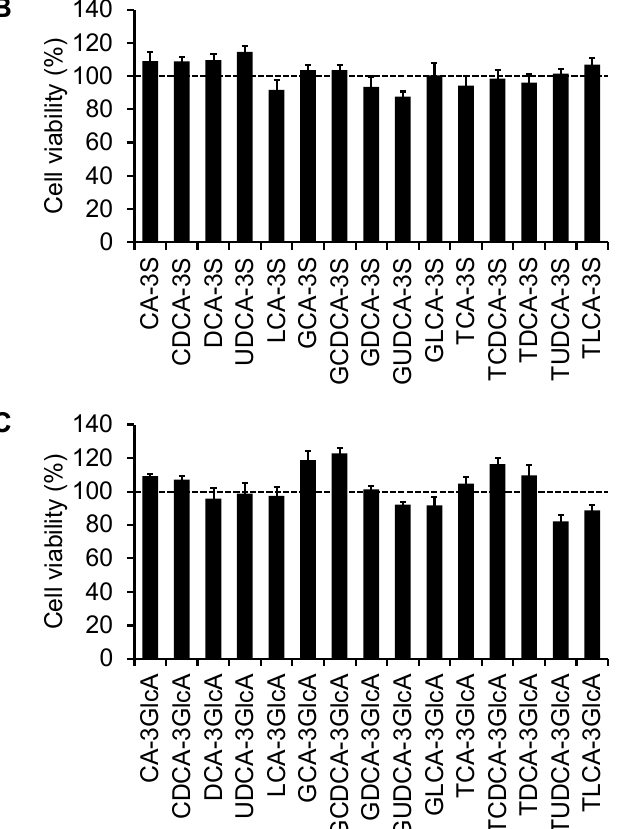
Figure 4. Effect of ( A ) unconjugated, glycine-conjugated, and taurine-conjugated bile acids, ( B ) bile acid 3-sulfates, and ( C ) bile acid 3-glucuronides on cellular viability. The bile acid concentrations were 50 µM for CA-3S, LCA-3S, TDCA-3S, LCA-3GlcA, and GLCA-3GlcA, and 100 µM for the other 40 types of bile acids. The OATP4C1-expressing cells were incubated for 10 min at 37 °C. After a 3 h color reaction, the absorbance was measured at 450 nm. Data are shown as mean ± standard error of the mean ( n = 5). Data are presented as the percentages of cell viability obtained from the control.